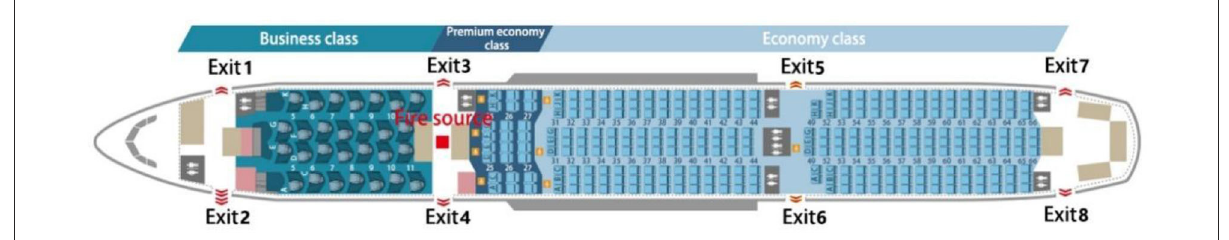
FIGURE3 Diagram of each Exit number and the location of the fire source in the passenger compartment.